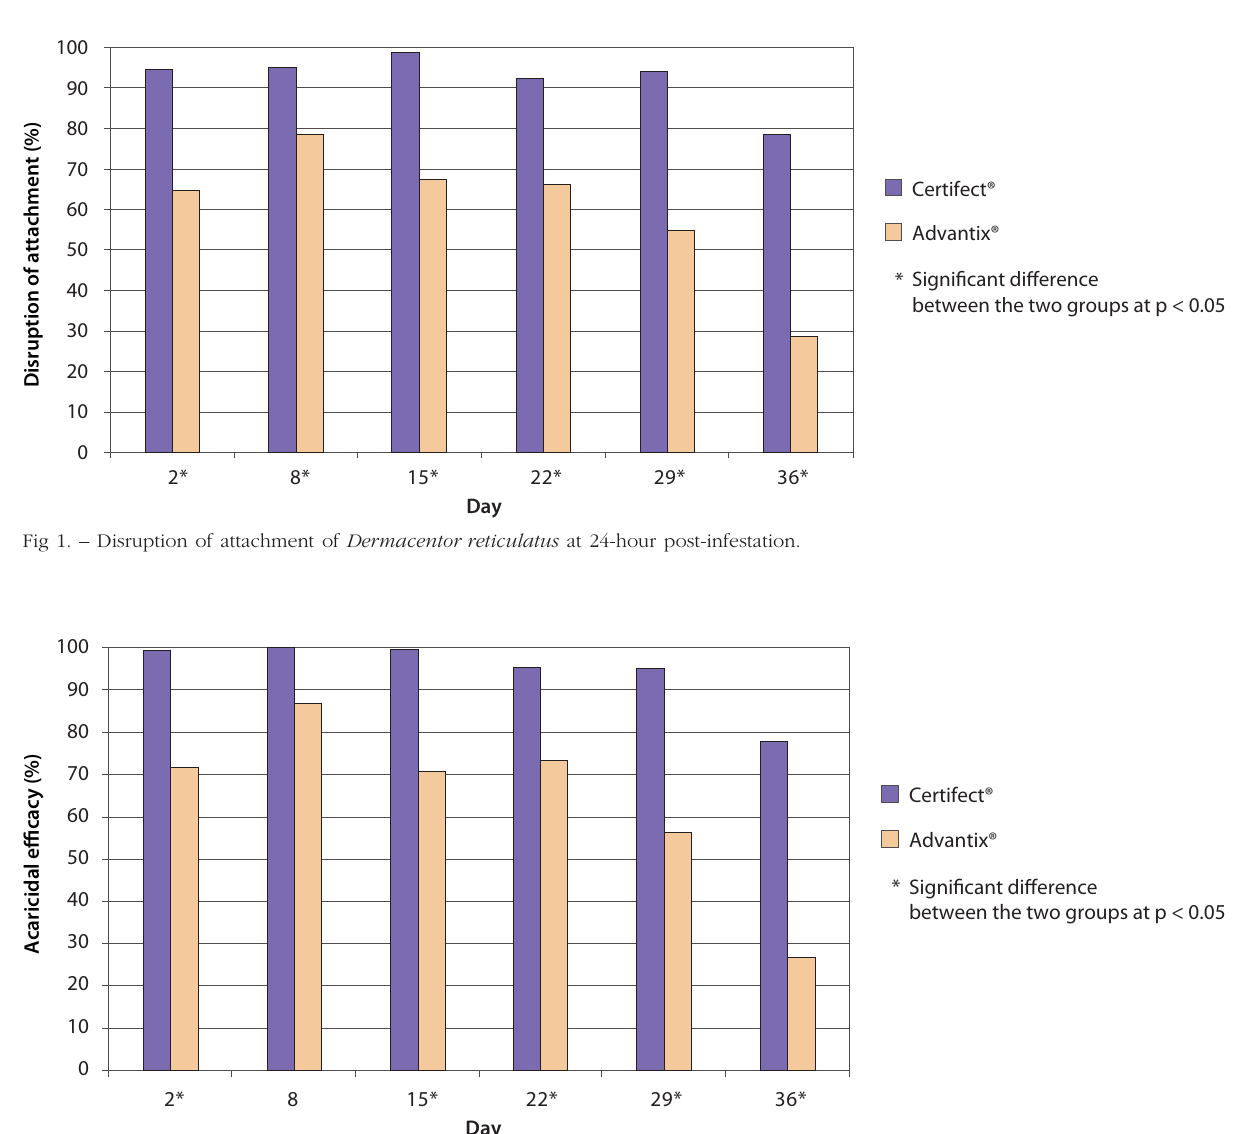
Table III. – Geometric means of Dermacentor reticulatus ticks counts by category at 24-hour post-infestation and percent of disruption of attachment and percent killing efficacy at 24-hour counts.